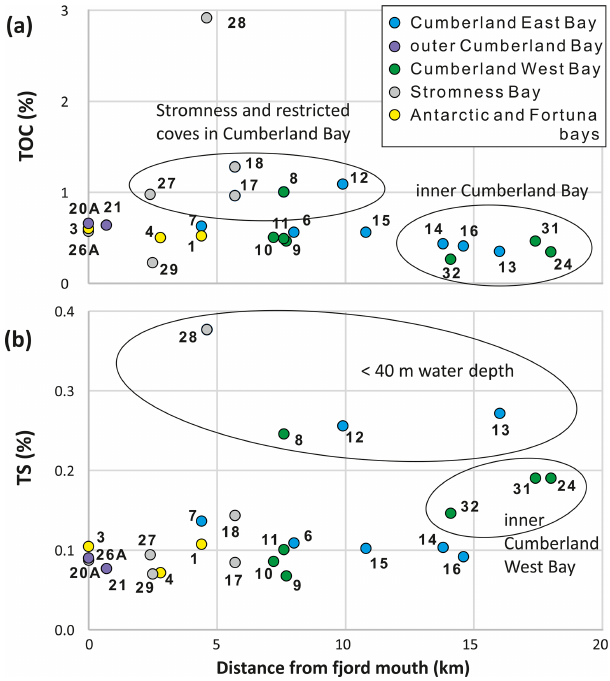
Figure 4. Total organic carbon (TOC) and total sulfur (TS) in rela- tion to distance from the fjord